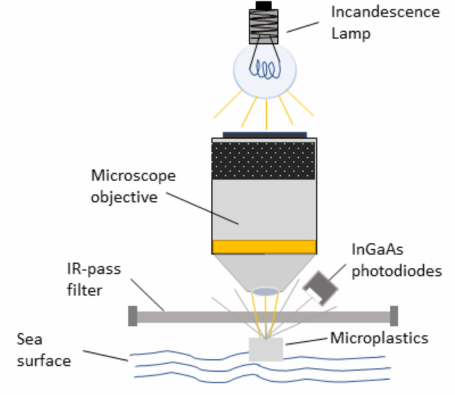
Figure 5. Schematic view of the microplastics